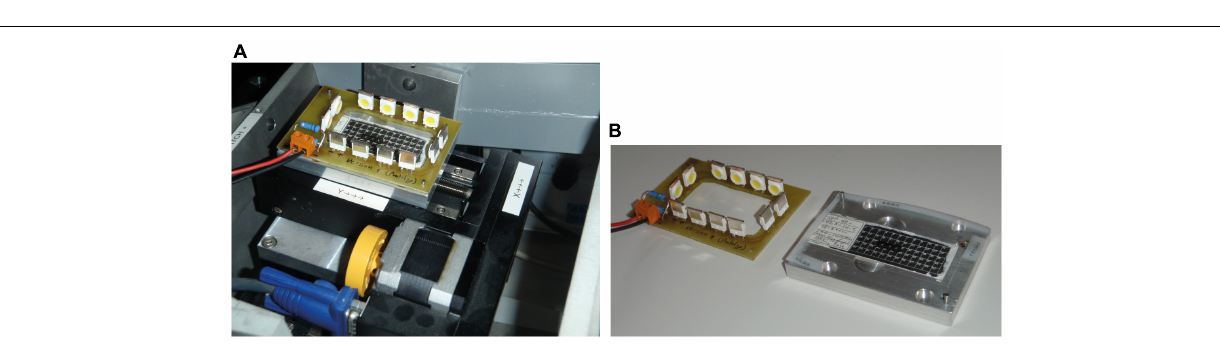
FIGURE 11 | “Lagrangian illumination.” (A) Lagrangian Illumination mounted on the stage of AMOR. (B) Langrangian Illumination disassembled, showing LEDs on a circuit board and the sample holder plate with an inserted multicellular slide. When mounted, an insulating foil is placed in between the sample holder and circuit board to avoid a short